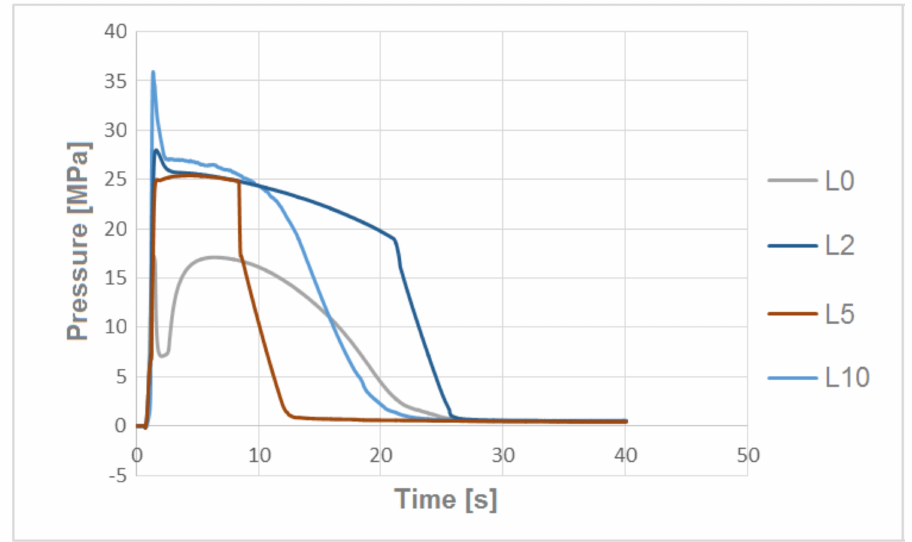
Figure 7. The pressure profiles in the mold cavity for composites filled with unmodified flax fibers and modified with alkalized 2%, 5% and 10% NaOH